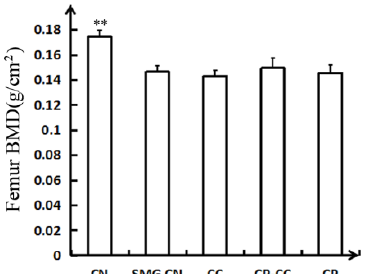
Figure 2. Femoral BMD determined by dual-energy X-ray absorptiometry analysis ( n = 6) CN, normal gravity control group; SMG CN, tail-suspended simulated microgravity control (SMG) groups; CC, SMG rats treated once-daily with 75 mg / kg calcium citrate (CC); CP–CC, SMG rats treated once-daily with 750 mg / kg bovine collagen peptide (CP) combined with 75 mg / kg CC; and CP, SMG rats treated once-daily with 750 mg / kg bovine CP. ** p < 0.01 vs. SMG CN.